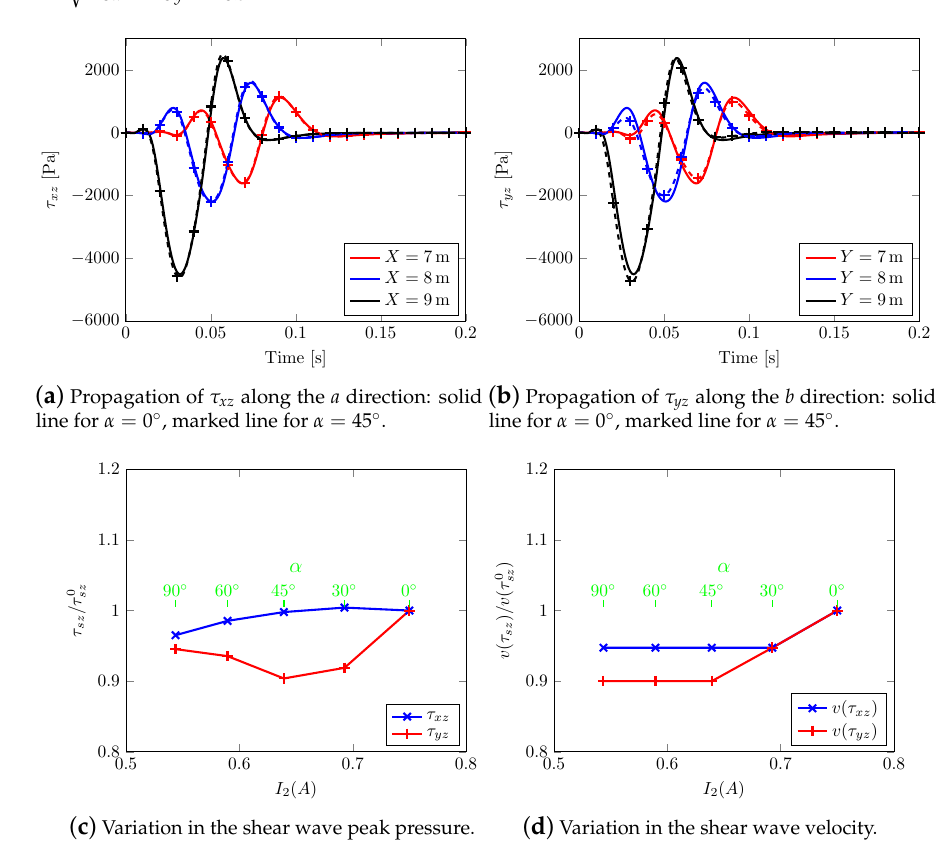
Figure 19. Effect of Biot’s coefficient tensor: effective shear stress component calculated along the horizontal